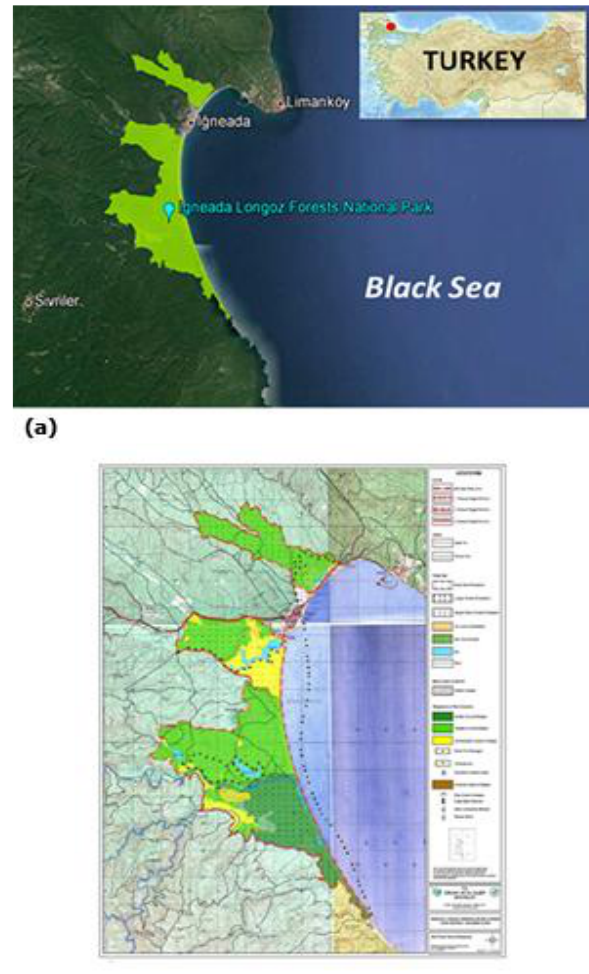
Figure 1. The location (a) and plan (b) of İğneada Floodplain Forests National Park (LTDRP, 2016).